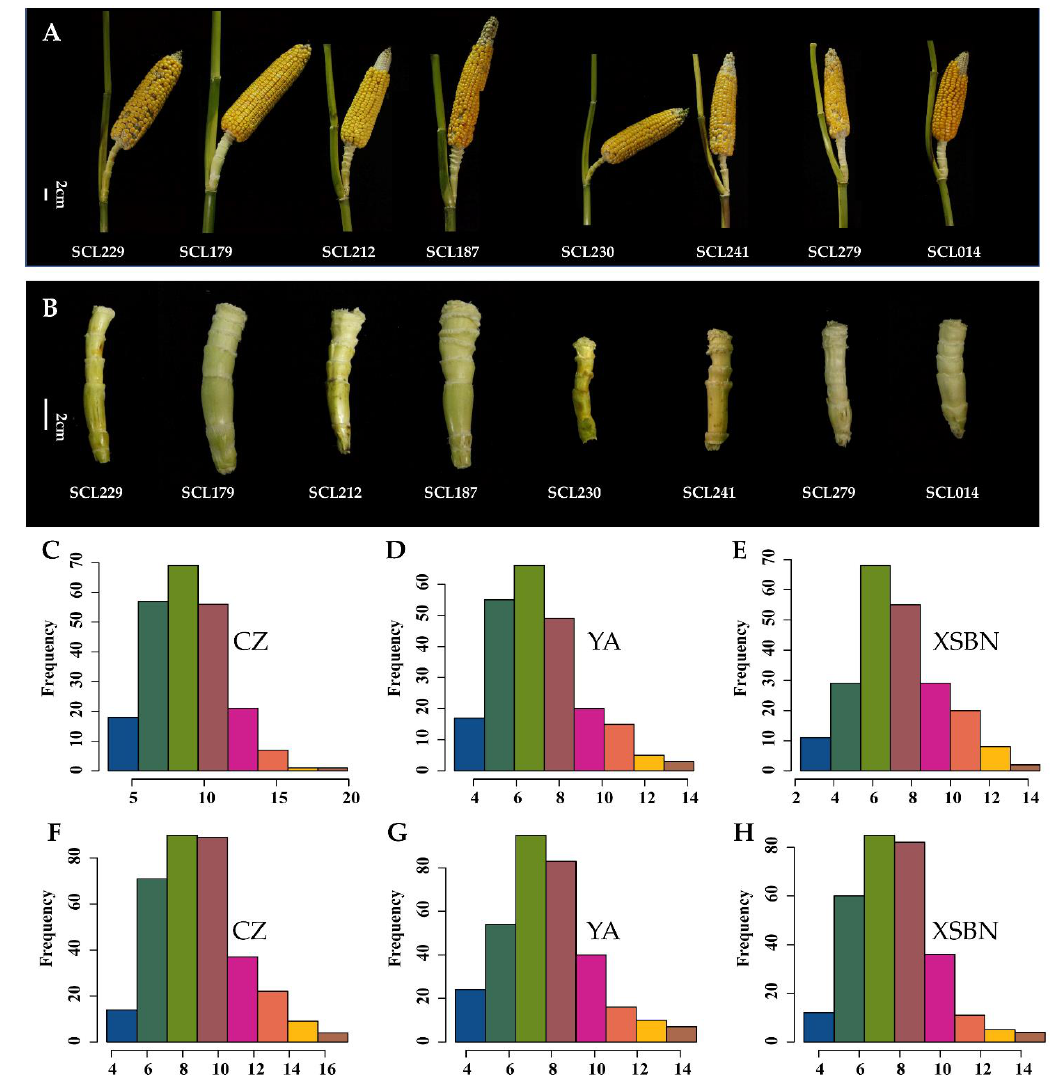
Figure 1. Frequency distributions of ear shank length. ( A ) Ears and shanks of different lines from the association panel, Scale bar, 2 cm; ( B ) Ear shank lengths of different lines from the association panel, Scale bar, 2 cm. ( C – E ) Frequency distribution of ear stank lengths in the IBM Syn 10 DH population. X-axis shows ear shank length (cm). ( F – H ) Frequency distribution of ear shank lengths in the IBM Syn 10 DH population. X-axis shows ear stank length (cm). CZ, YA, and XSBN represent the environments Chongzhou, Ya’an, and Xishuangbanna, respectively.